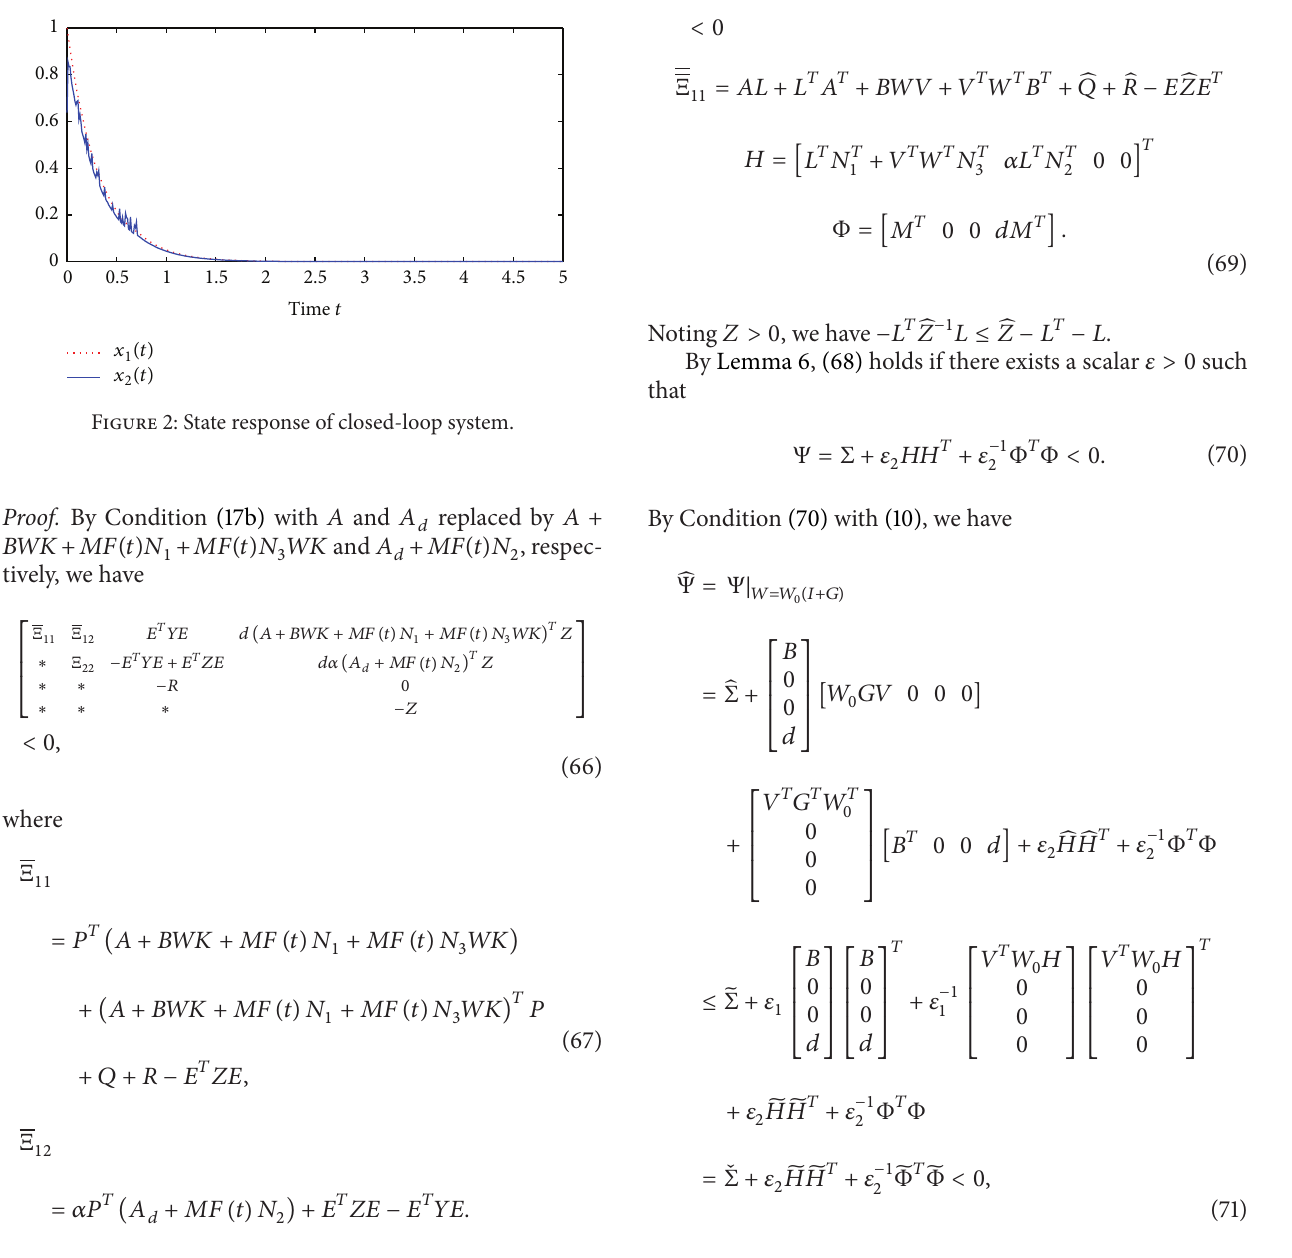
Figure 1: State response of open-loop system.